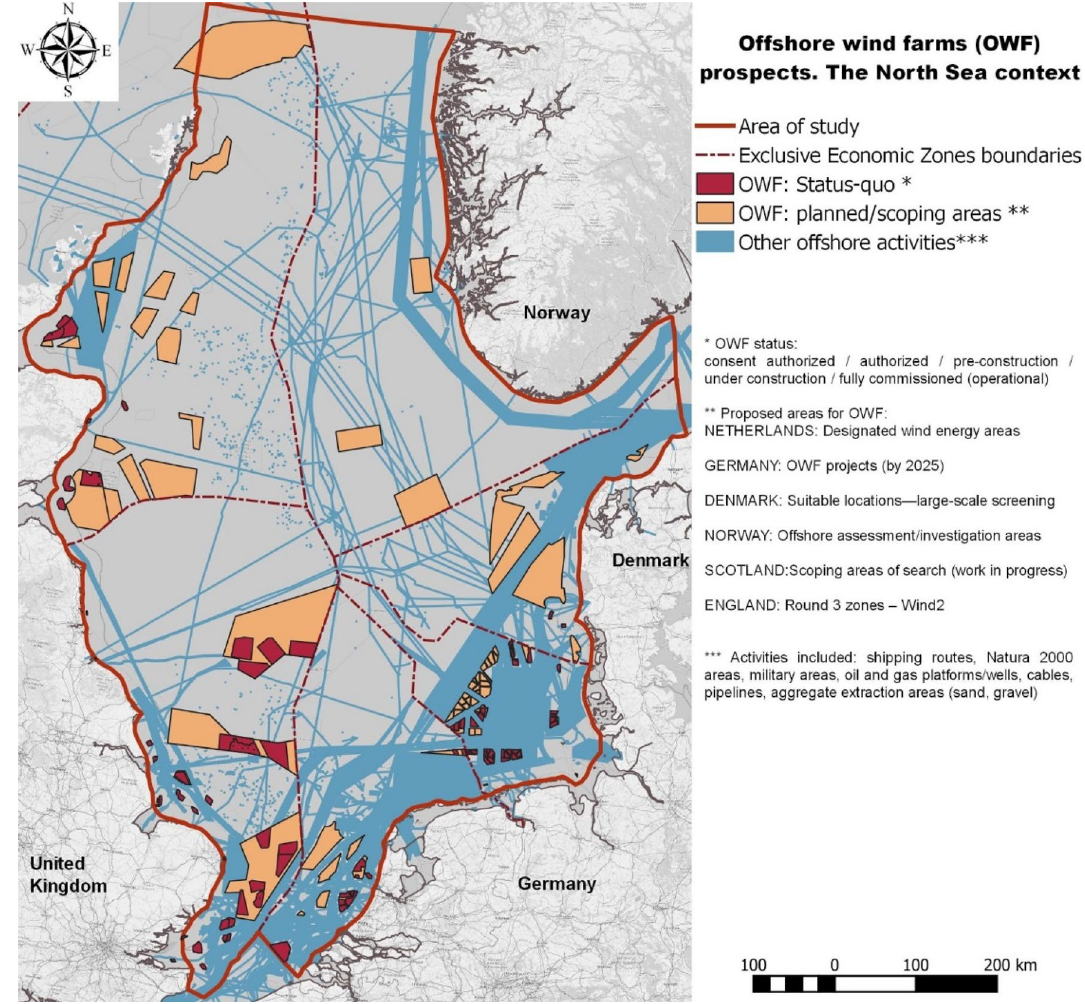
Figure 6. Offshore wind farm prospects (existing/authorised/planned) in the North Sea